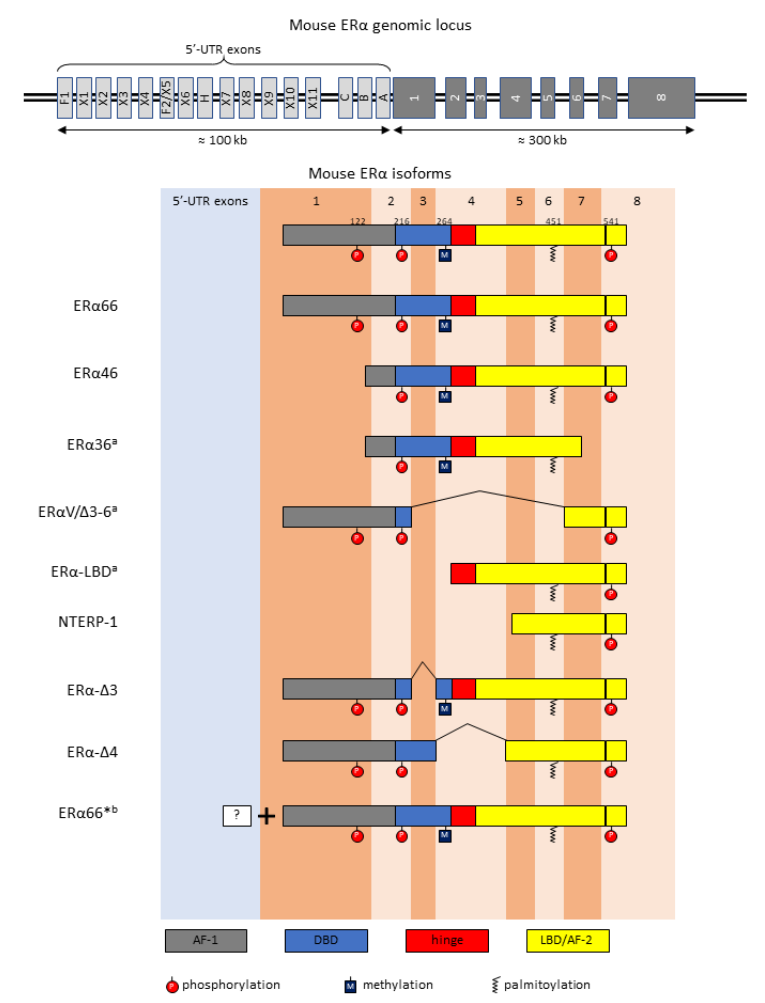
Figure 1. Mouse ER α gene organization, alternative splicing isoforms, and post-translational mod- Figure 1. Mouse ERα gene organization, alternative splicing isoforms, and post -translational mod- ifications discussed in the review. Mouse ER α gene organization is based on Ishii et al. and ifications discussed in the review. Mouse ERα gene organization is based on Ishii et al. and Kos et Kos et al. [5,6]. The illustration does not reflect actual lengths of exons and introns. ER α func- tional domains are aligned along their coding exons. Exon numbering is based on full-length ER α